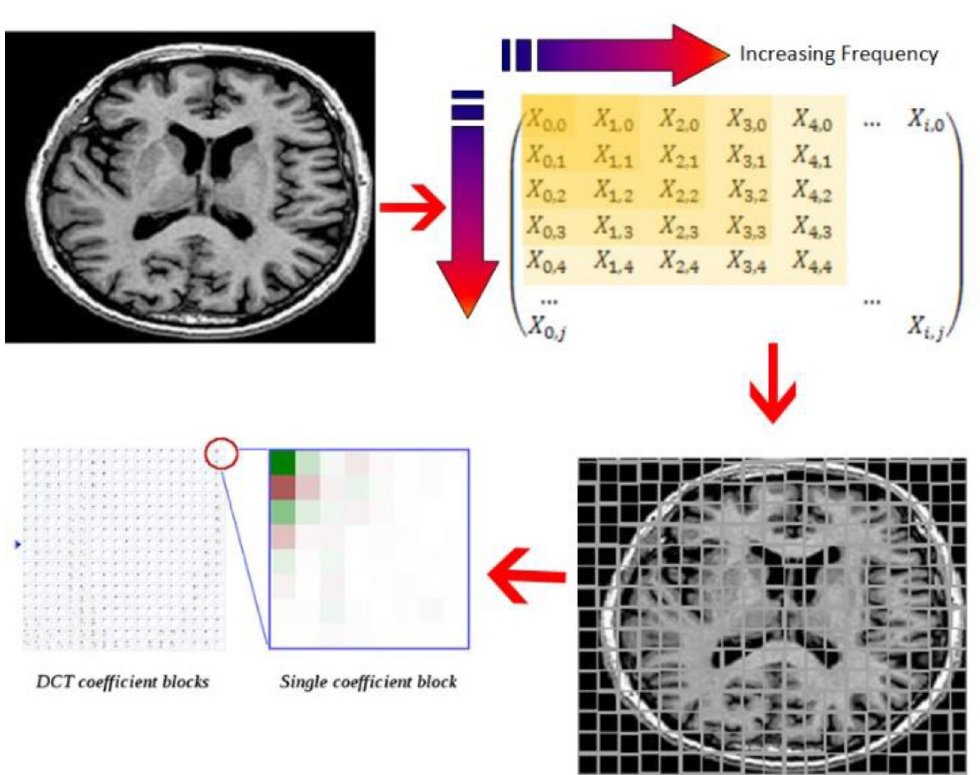
Fig 3. DCT coefficient for matrix